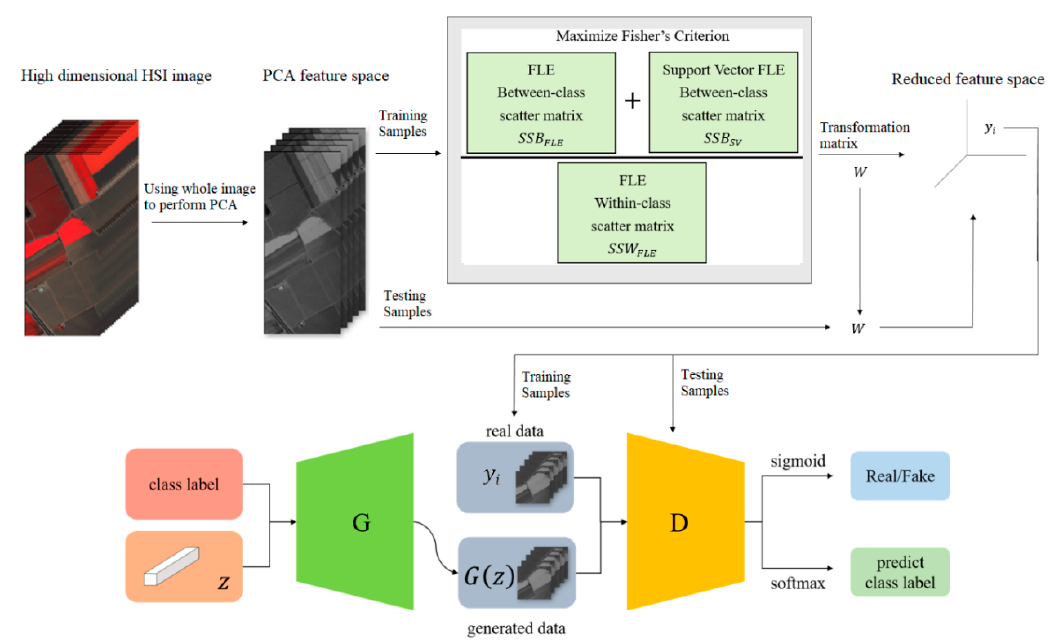
Figure 1. The framework of SVMFLE DR with a GAN classifier.